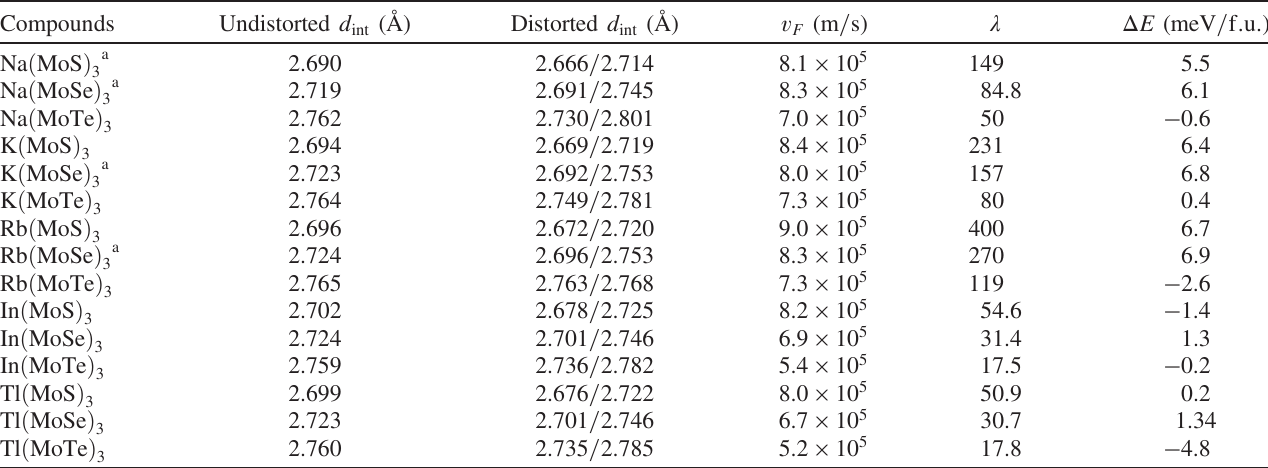
TABLE III. Calculated intertriangle Mo-Mo bond length ( d the A point for undistorted structure, anisotropy parameter λ for undistorted structure, and Peierls stabilization energy Δ E (the total energy difference between undistorted and distorted structures) for 15 A ð MoX Þ 3